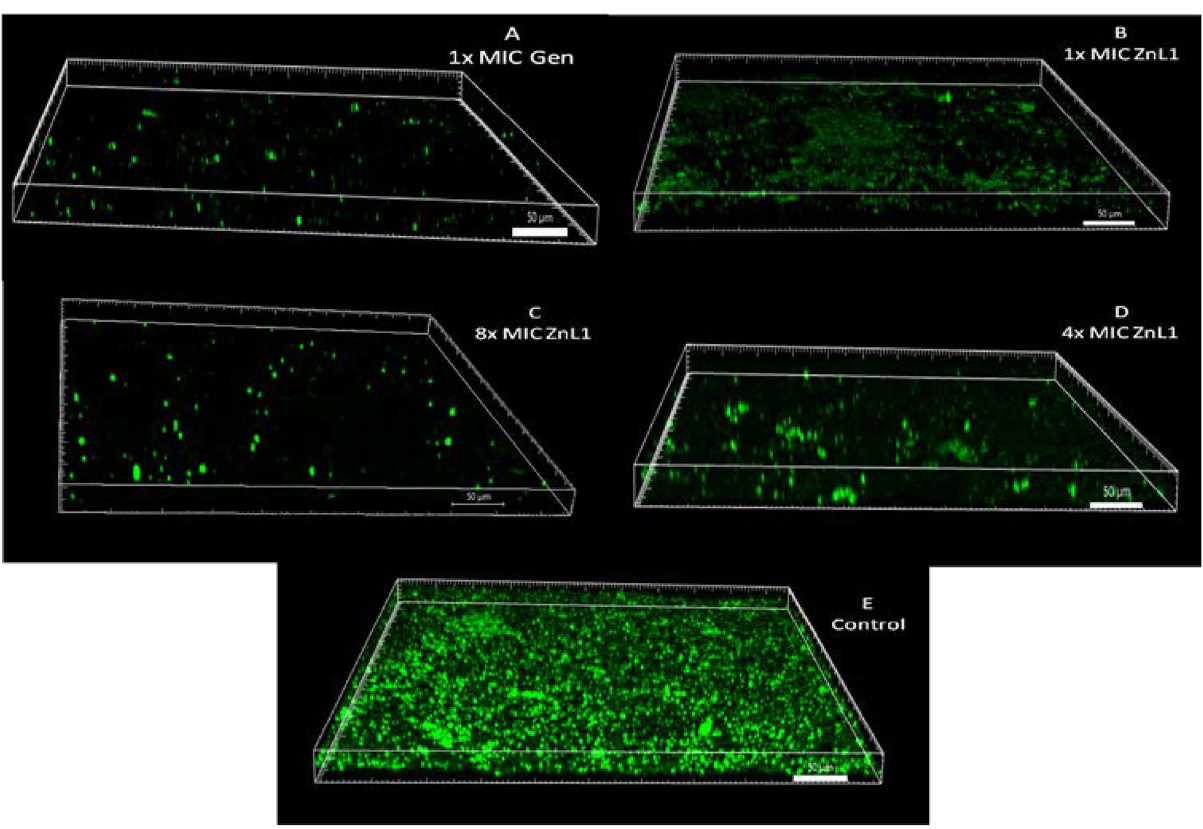
Figure 9. Representative CLSM images of A. baumannii analysed on the working electrode ( A ) Cells exposed to 1 × MIC, Gen ( B ) Cells exposed to 1 × MIC, ZnL1 ( C ) Cells exposed to 8 × MIC, ZnL1 ( D ) Cells exposed to 4 × MIC, ZnL1 ( E ) Untreated